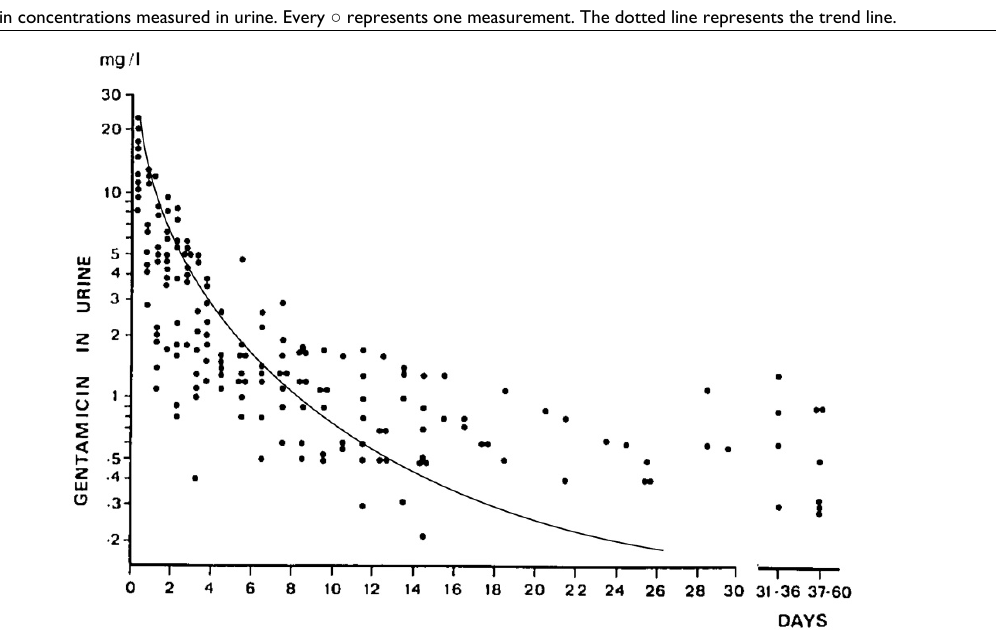
Figure 3: Gentamicin concentrations measured in urine in patients treated with PMMA cements. Figure re-published from Törholm et al. 7 with permission from Wolters Kluwer Health, Inc. The line represents the trend line from Fig 2 for